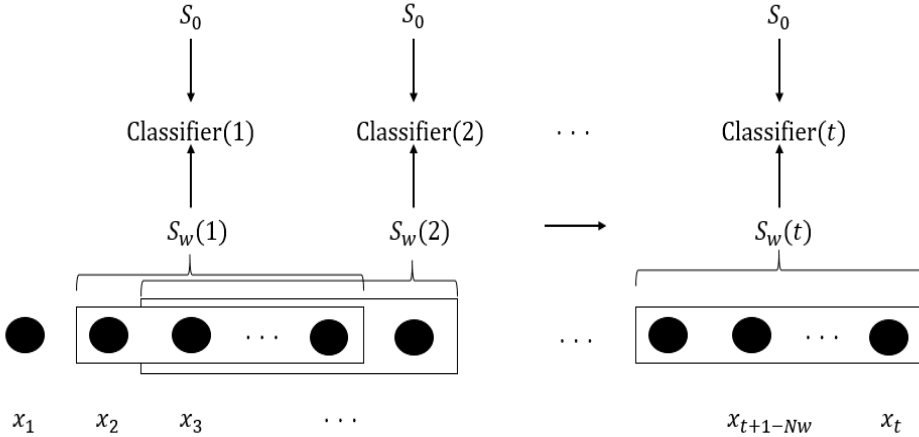
Figure 1. Framework for real-time contrast (RTC) control chart.